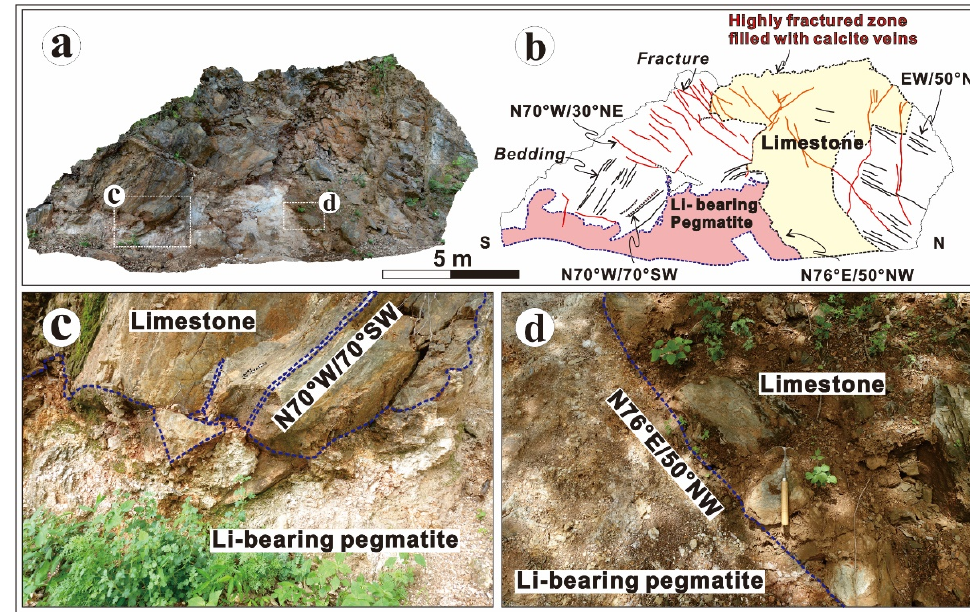
Figure 9. Rare ‐ element pegmatite (REP) body Pgt 7 in the limestone outcrop. ( a , b ) Pgt 7 is irregularly shaped, the host rock is highly fractured, and the bedding is folded based on the REP body. ( c ) The southern boundary is bent, and a thin REP intrudes along the bedding. ( d ) The northern boundary lies parallel to the bedding.